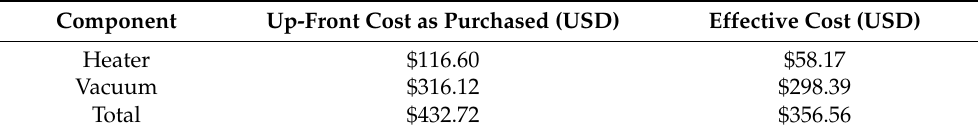
Table 7. Cost breakdown of the vacuum